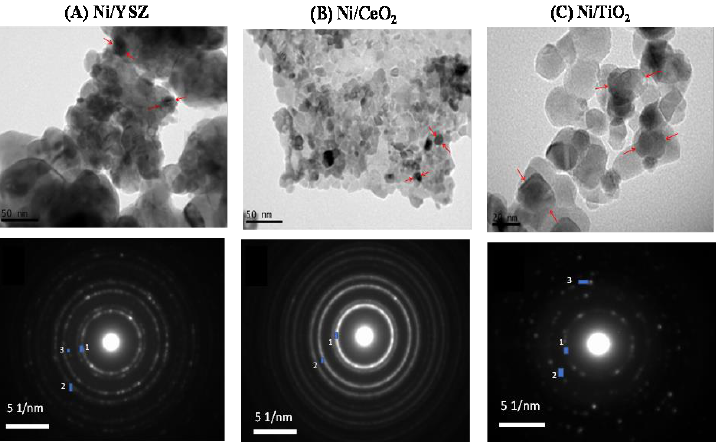
Figure 2. TEM images and Selected Area Electron Diffraction (SAED) patterns obtained for ( A ) 5%Ni/YSZ, ( B ) 5%Ni/CeO 2 and ( C ) 5%Ni/TiO 2 catalysts. Ni particles are indicated with red